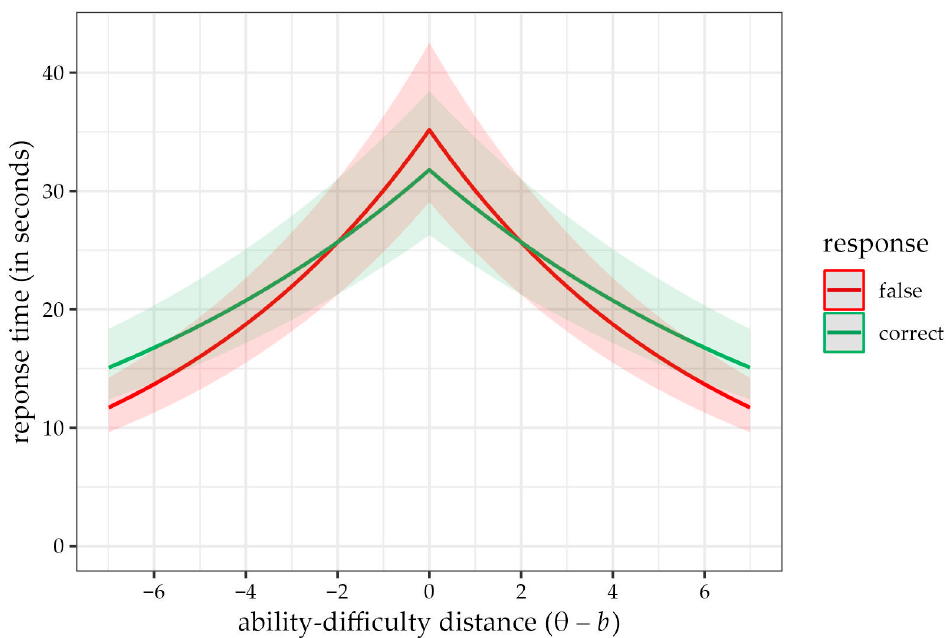
Figure 4. Predicted response time values according to Model B3 as a function of ability–difficulty distance separated by whether the answer was correct (green) or incorrect (red). Regardless of the response correctness, items whose difficulty matches the participant’s ability level take the longest time to solve (with incorrect answers taking the longest). The relationship changes for very difficult and easy items—with these, correctly answered items take longer than the incorrect ones.